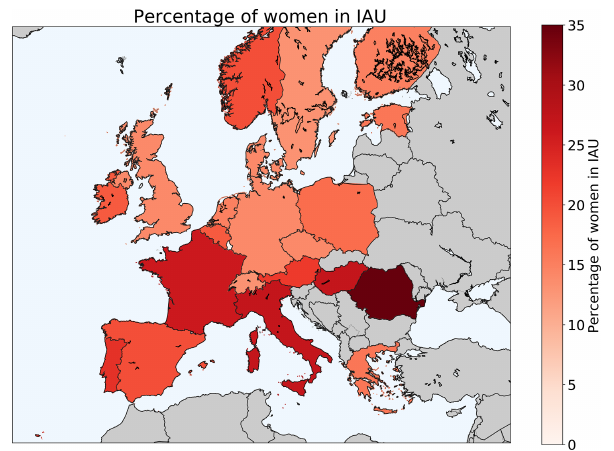
Figure 5. The evolution of women’s percentage in the IAU from ESA’s Member State over the period